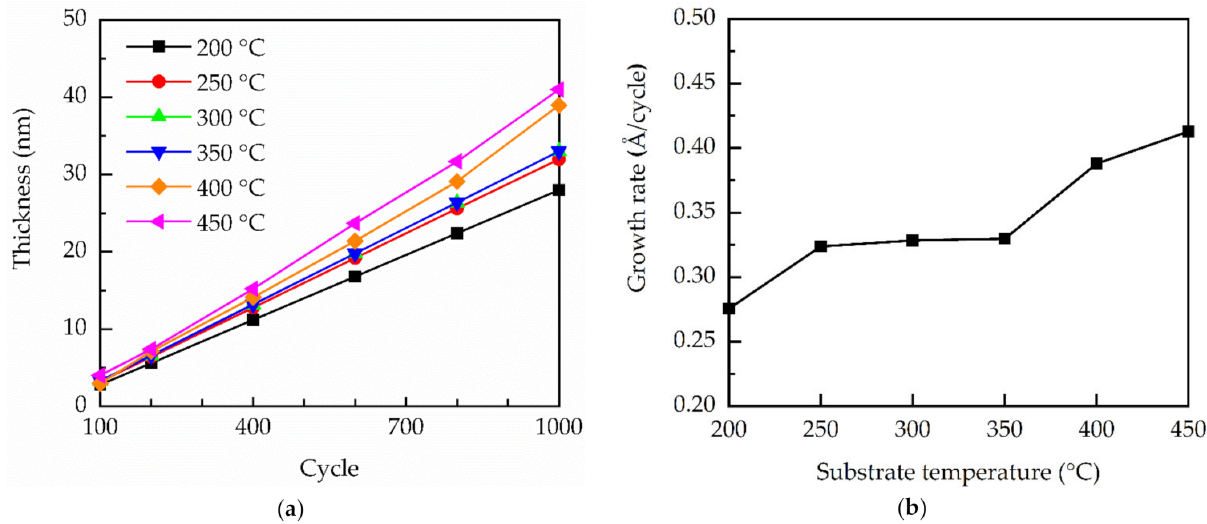
Figure 2. ( a ) Thickness of GaN films versus ALD cycle number for different substrate temperatures; ( b ) GPC of GaN films with different substrate